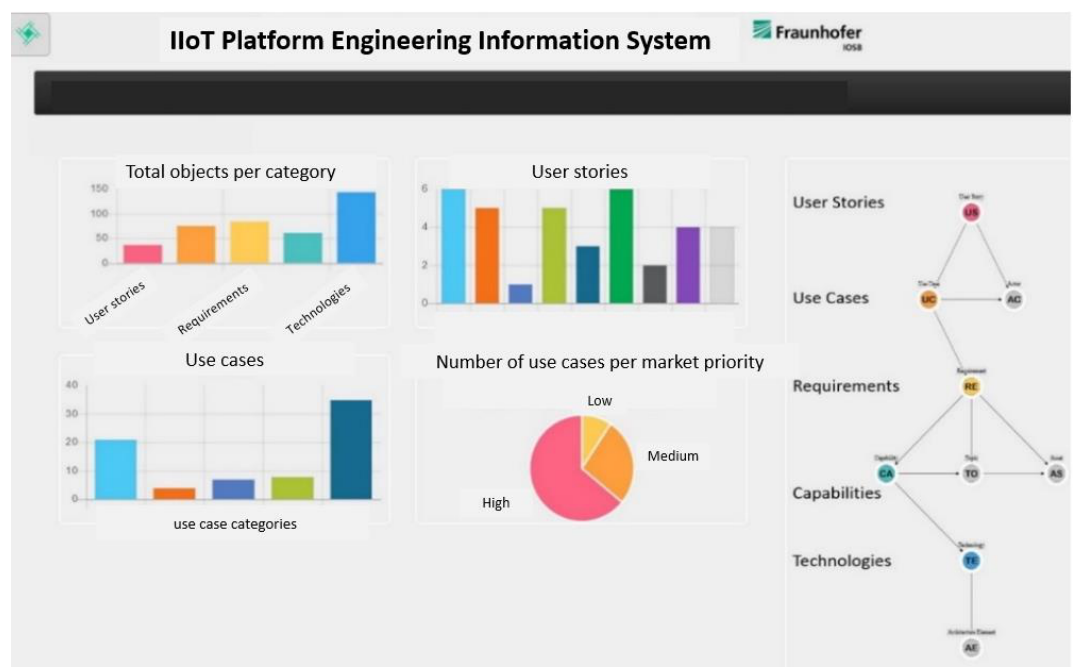
Figure 9. Dashboard of the IIoT Platform Engineering Information System (PEIS).